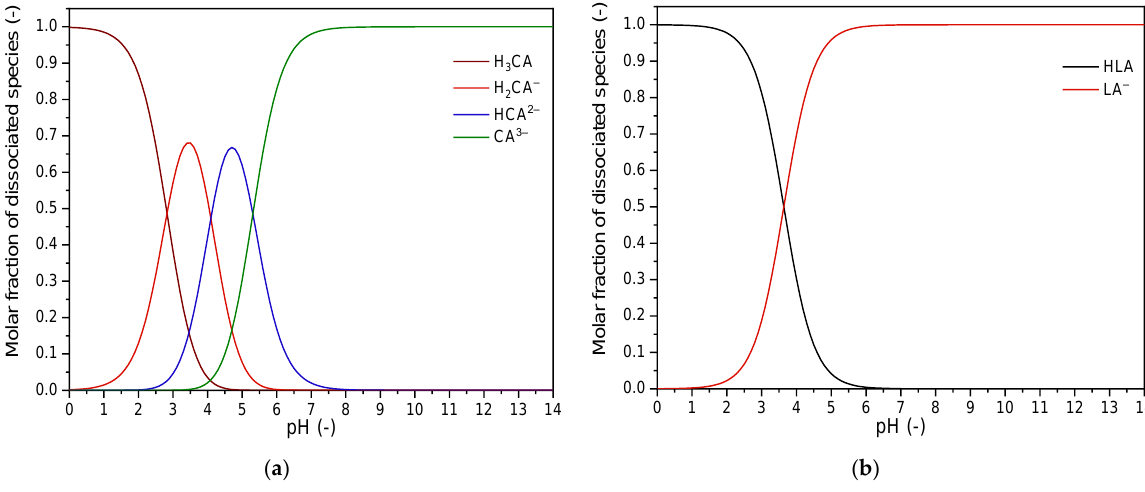
Figure 3. The molar fraction of ( a ) dissociated citric acid species; ( b ) dissociated lactic acid species. Figure 3a shows that the citric acid is wholly dissociated with the corresponding spe- cies in the operating pH range of diluate (pH 5.12 – 4.76). In contrast, lactic acid (Figure 3b) is presented in non-dissociated form, ranging from 3% at pH 5.12 to 8% at pH 4.76. How- ever, the removal efficiency of citrates was not as significant as that of lactates, which is explained by the higher hydrodynamic radius and lower diffusion coefficient of the citrate anions compared to the lactate anion. In comparison, the absolute content of lactates was reduced by 42.0% ± 3.0% and 78.4% ± 2.2% for the LML R70 and LML R90, respectively, while the absolute citrate content was reduced by 15.7% ± 6.8% and by 34.0% ± 1.8% for the LML R70 and the LML R90, respectively. The average composition of diluted LML (feed), demineralized LML R70 and LML R90 are presented in Table 3. Table 3. Conductivity, pH, mineral and organic composition of initial and desalted LML samples. Parameter 15.87 ± 0.7 Data are the average of 4 repetitions with a confidence level of P = 0.95.